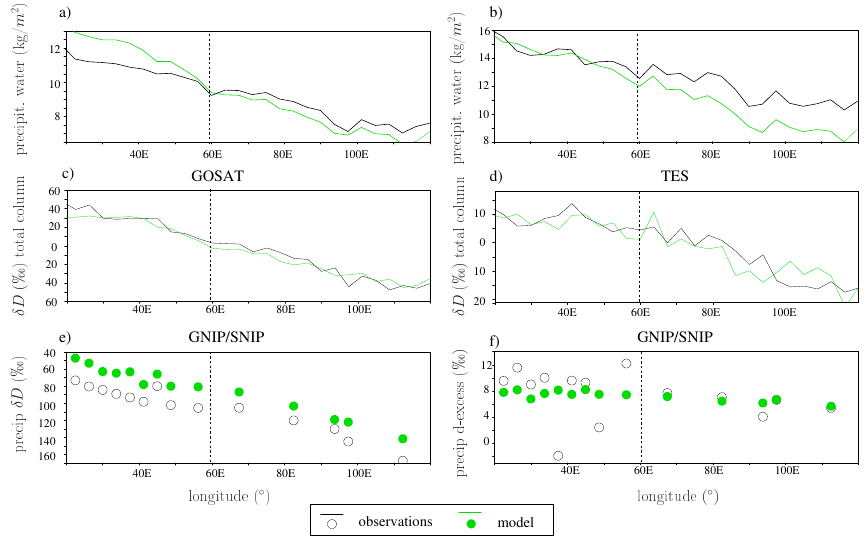
Figure 5. Annual mean east–west transects of observed (black) and simulated (green) precipitable water observed by GOSAT (a) and by TES (b), δD in the total column water vapor as observed by GOSAT (c) and by TES (d), δD in the surface precipitation (e) and d-excess in the surface precipitation (f). Transects are taken around the latitude of Kourovka: 50–64 ◦ N. For satellite data sets, the annual-mean δD averaged over 20–120 ◦ E–50–64 ◦ N is subtracted to focus on the longitudinal variations. LMDZ outputs are collocated with each data set and averaging kernels are applied to compare with satellite data sets. The dashed line indicates the longitude of Kourovka.